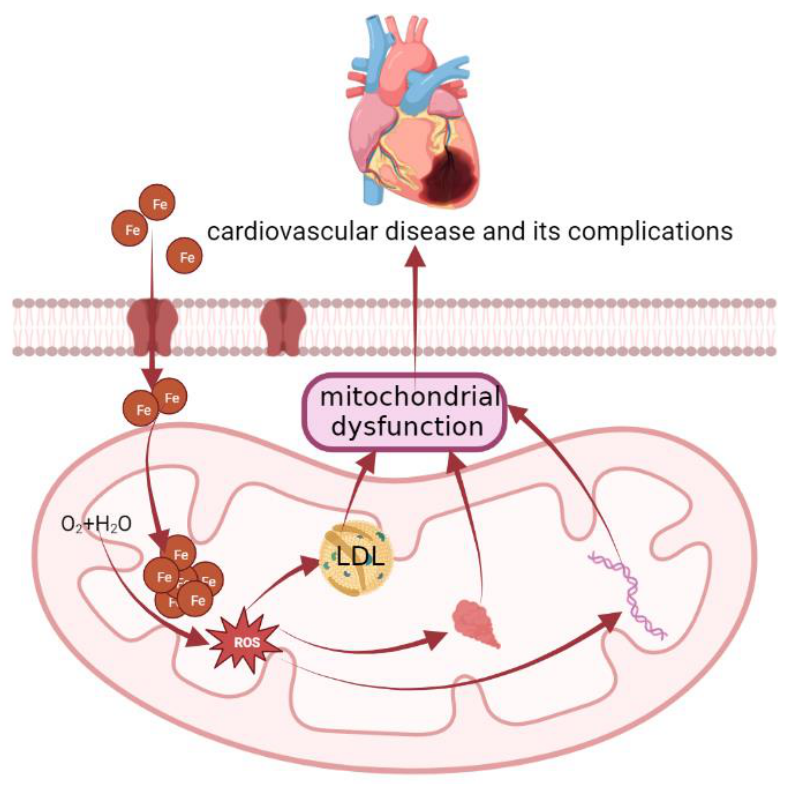
Figure 2. The molecular mechanism of cardiovascular disease. Concerning the mechanisms, the elevation in mitochondrial iron levels that results in heart failure is likely mediated by potential disruption of Fe-S cluster biogenesis and by an ROS-dependent mechanism. Iron is specially involved in the formation of atherosclerosis by catalyzing the generation of ROS, promoting the peroxidation of the lipid and protein parts of lipoproteins, and forming oxidized low-density lipoprotein (LDL). ROS causes mitochondrial damage by attacking mitochondrial DNA and mitochondrial proteins, impairing mitochondrial aerobic metabolism, and mitochondrial dysfunction will also increase the production of ROS, thereby forming a vicious circle, which ultimately manifests as cardiovascular disease and its complications. Meanwhile, oxidized-LDL can induce macrophages to form foam cells and promote the development of